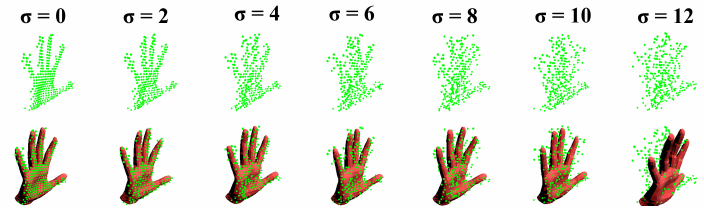
Figure 14. The influence of the standard deviation of noise on the point cloud from synthetic depth images. The visible performance of our system with those